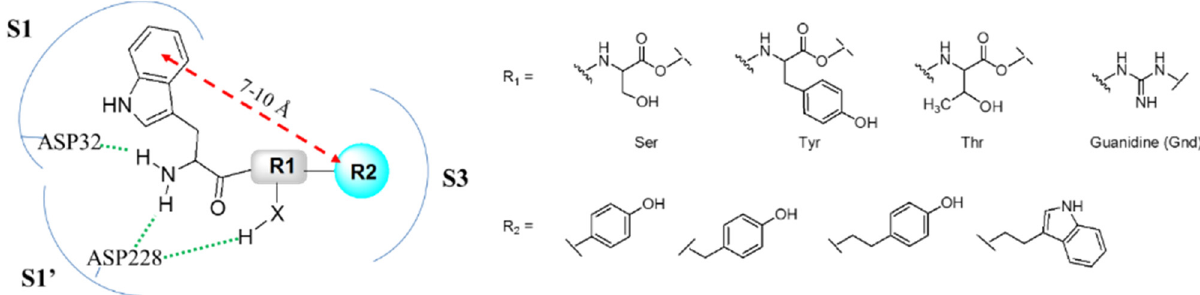
Figure 1: The proposed designed compounds ( X = O or N atom )